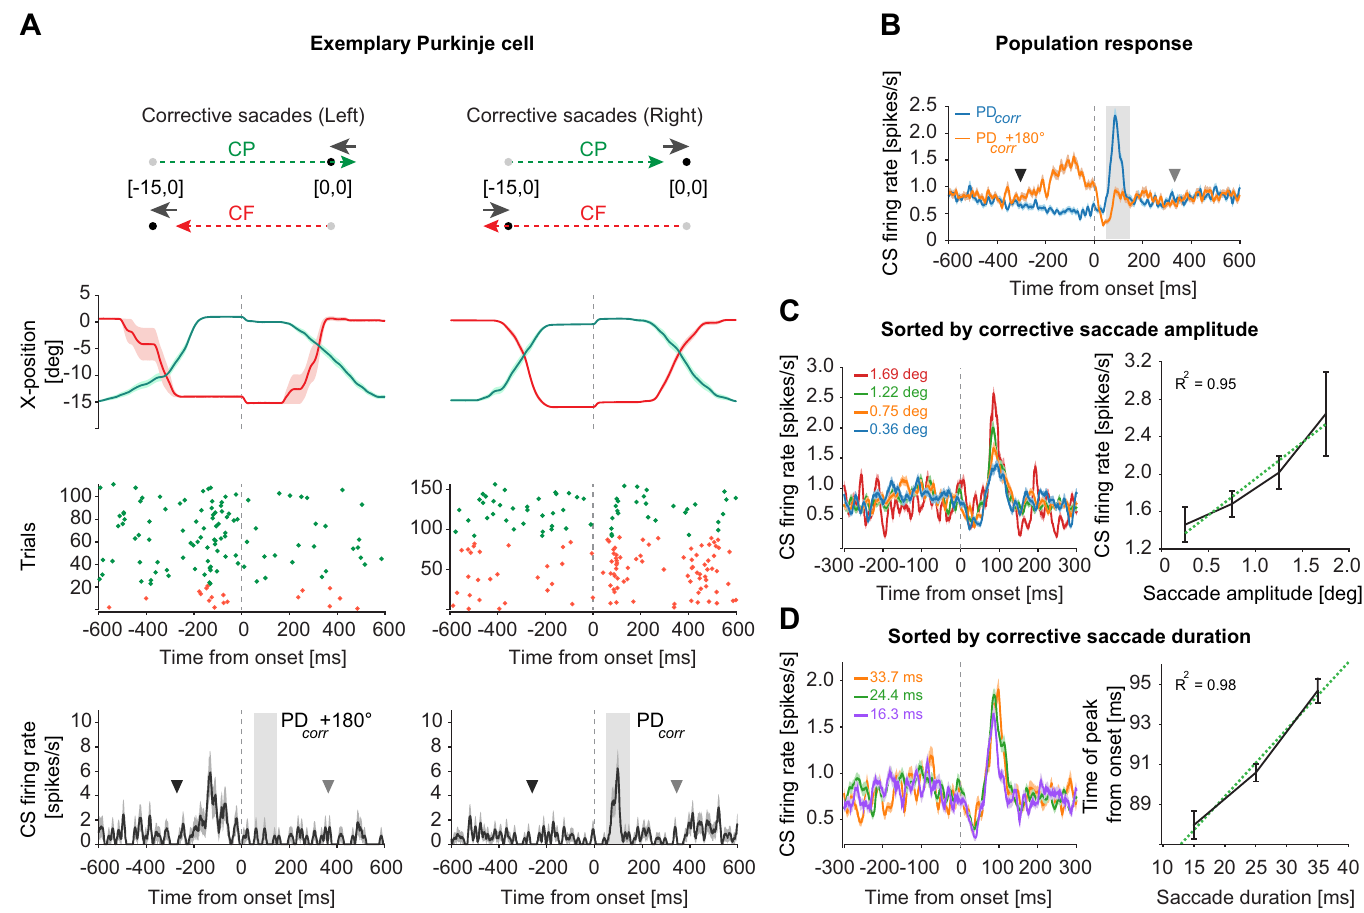
Fig 3. CSs encode corrective saccade direction, amplitude, and duration during the “postcorrective saccadic period” . (A) CS response of an exemplary PC to corrective saccades in leftward (left panels) and rightward direction (right panels). As illustrated by the schematic diagram on the top, supported by averaged ( ± SEM) saccade trajectories underneath, an experimental session with left CF (red) and right CP (green) saccades resulted in leftward corrective saccades that were made to correct the leftward error arising from CP saccades that “overshot” the fixation dot, and CF saccades that “undershot” the target location (left panel). The start and end positions of these corrective saccades were naturally different. Similarly, rightward corrective saccades resulted from overshooting CF and undershooting CP saccades (right panel). As seen in raster plots (middle panels) and the mean ( ± SEM) firing response of all trials (bottom panel), the peak firing rate of CSs was much larger for rightward (right panel) as compared to leftward (left panel) corrective saccades during the “postcorrective saccadic period” of 0–100 ms from corrective saccade end (gray shaded region). For each PC, CS’s preferred direction for corrective saccades (PD corr ) was based on this period. Note that neither the different starting positions of corrective saccades nor the direction of preceding primary saccades influenced the CS firing. The average time of the preceding CF saccade offsets (= 272 ms) and the upcoming CP saccade onsets (= 362 ms), relative to corrective saccade onset, is marked by inverted black and gray triangles, respectively. (B) CS population response (mean ± SEM; N = 151 PCs) sorted by PC’s preferred (PD corr ) and antipreferred (PD corr +180˚) direction of corrective saccades based on “postcorrective saccadic period” (gray shaded region). Note that the CS activity during the “precorrective saccadic period” of approximately − 200 to 0 ms from corrective saccade onset was used for determining the CS’s preferred direction of errors (PD error ). The average time of the preceding CF saccades offsets (= 305 ms) and the upcoming CP saccade onsets (= 331 ms), relative to corrective saccade onset, is marked by inverted black and gray triangles, respectively. (C) CS population response (mean ± SEM, PD combined) sorted by different amplitudes (left panel). The relationship between saccade amplitudes and peak firing rate of CSs is shown on the right. (D) CS response (mean ± SEM) to corrective saccades of different durations (left) and the corresponding relationship between the timing of peak response (bootstrapped mean ± confidence intervals) and saccade duration (right). Green dotted lines represent the linear regression fits. All data are aligned to corrective saccade onset. Underlying data available from the Dryad Digital Repository: [https://doi.org/10.5061/dryad.d51c5b03m]. CF, centrifugal; CP, centripetal; CS, complex spike; PC, Purkinje